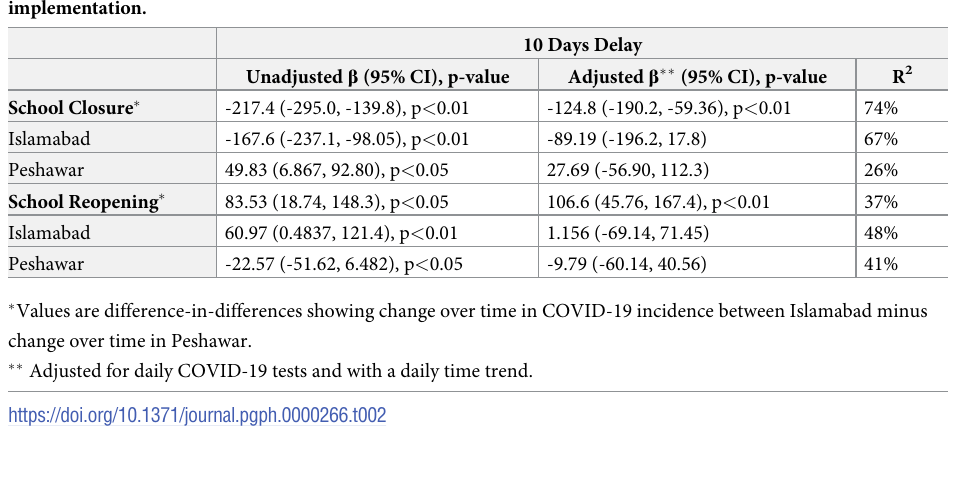
Table 2. Difference in COVID-19 incidence pre- and post- school closure and re-opening across Islamabad and Peshawar and between pre-and post- implementation in Islamabad and Peshawar 10 days after NPI implementation.